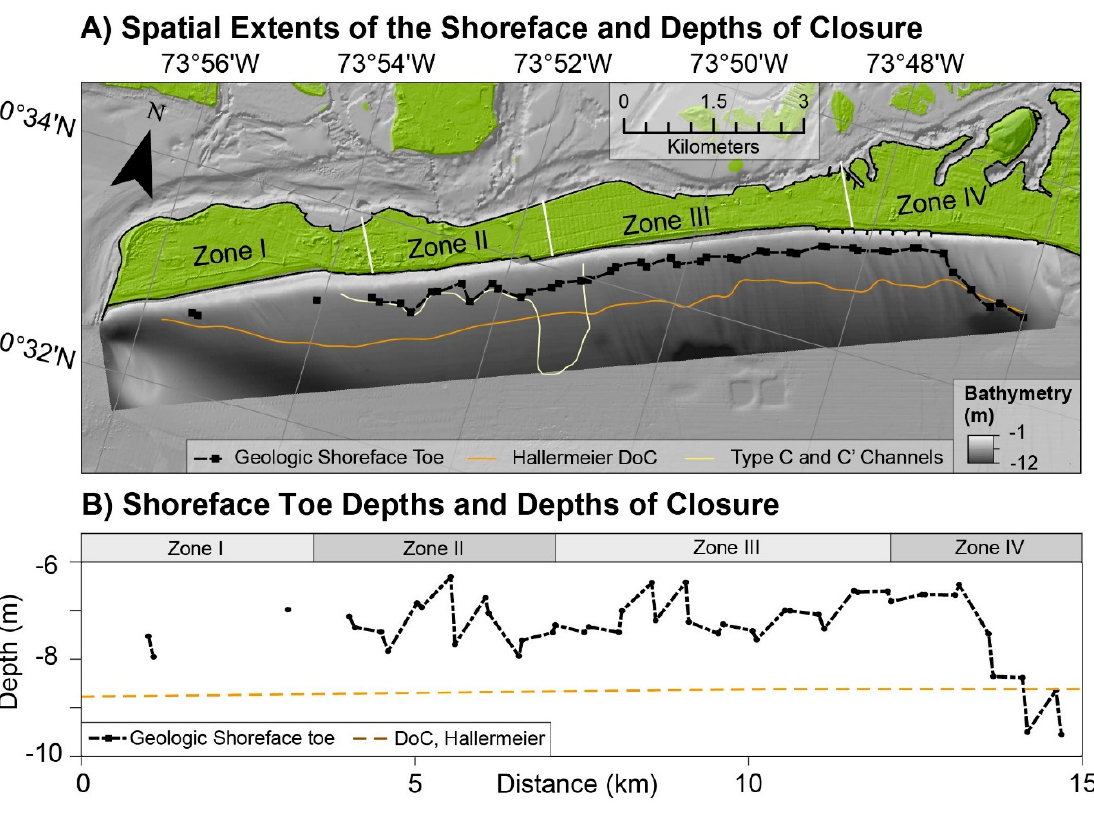
Figure 13. ( A ) Spatial extents of the geologic shoreface toe and Hallermeier [60] inner depth of closure (DoC) are superimposed on a map of bathymetry. The extent of type C and C’ channels are spatially coincident with widening shorefaces in zone II. ( B ) The depths of geologic shoreface toes are plotted with the Hallermeier [60] inner depth of closure.